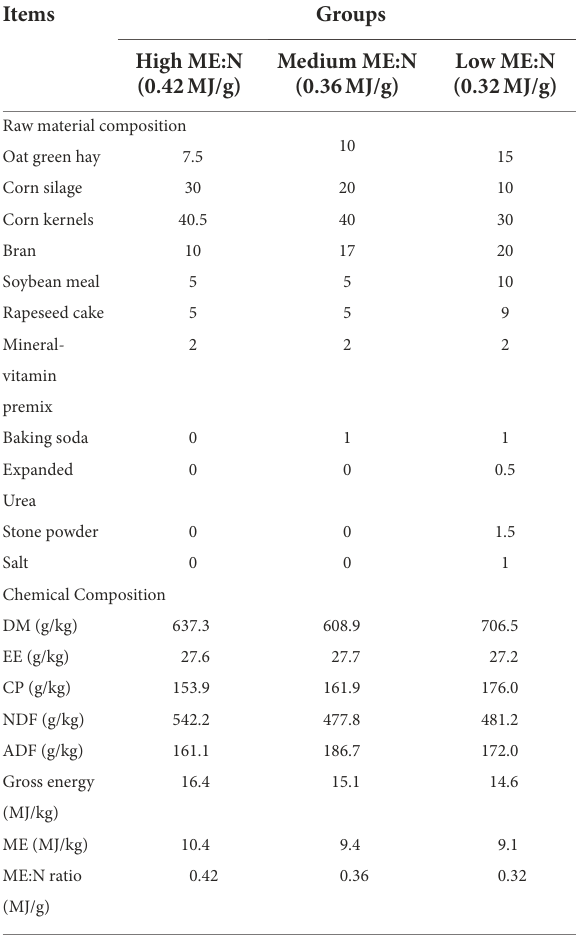
TABLE 1 Dietary components and chemical composition of diets with different ME:N ratios (DM basis).